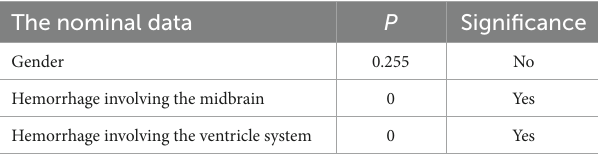
TABLE 1 Correlation between nominal data and the status of consciousness by Mann–Whitney U test.